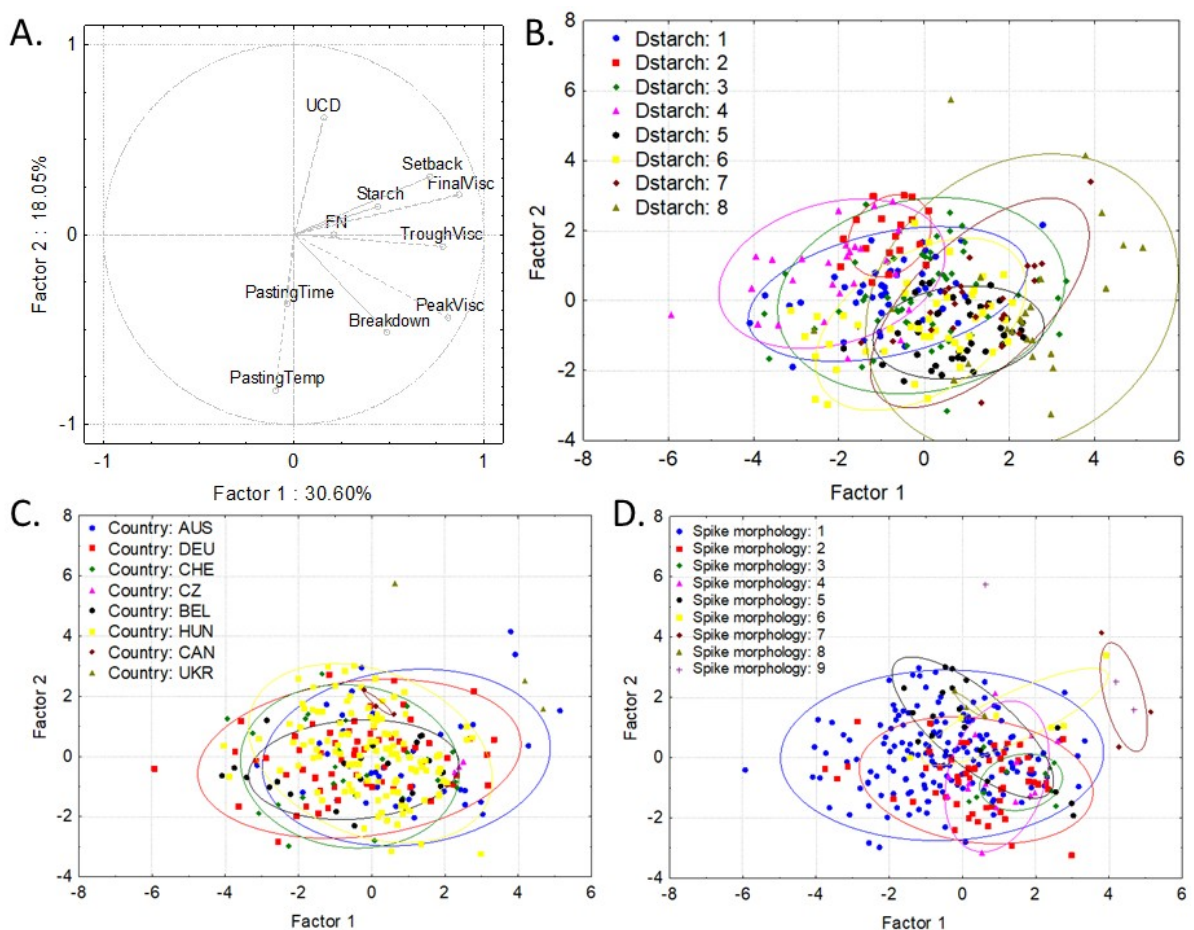
Figure 4. Principal component analysis based on the starch properties of spelt ( A ) and grouped by the groups formed by the hierarchical cluster analysis ( B ), country ( C ), and spike morphology ( D ) groups (where the most determinant traits that contributed to Factor 1 were peak viscosity (0.8115) and final viscosity (0.8699), while it was pasting temperature ( − 0.8191) and starch damage (0.6144) for Factor 2). DevTime, dough development time; FN, falling number; Temp, temperature; UCD, starch damage; Visc, viscosity; Dstarch, groups formed by starch properties on dendrogram (Figure 2b); AUS, Australia; BEL, Belgium; CAN, Canada; CZ, Switzerland; CHE, Czech Republic; DEU, Germany; HUN, Hungary; UKR, Ukraine. Spike morphology: (1) awnless, red, spelt-type spike; (2) awnless, white, spelt-type spike; (3) awned, black, spelt-type spike; (4) awned, red, spelt-type spike, (5) awned, white, spelt-type spike; (6) awnless, gray, spelt-type spike; (7) awnless, gray, wheat-type spike; (8) awnless, white wheat; and (9) awned, white wheat.